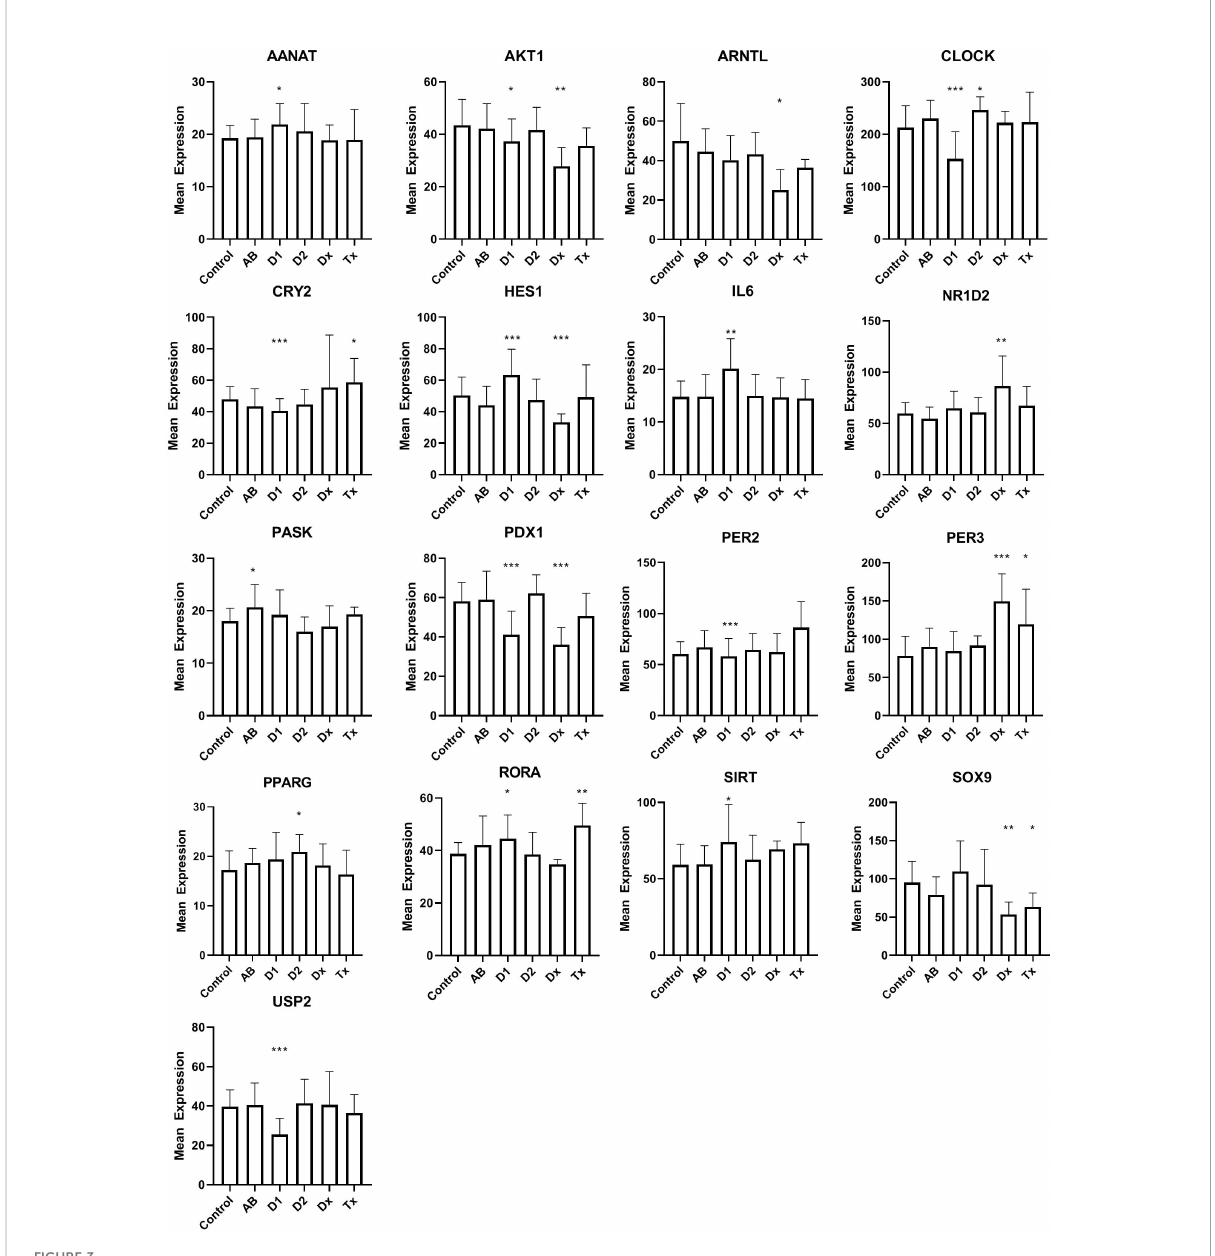
FIGURE 3 Expression levels of selected genes related to circadian rhythm in islet of Langerhans. See Figure 1 for patient groups and statistics. *p<0.05, **p<0.01,